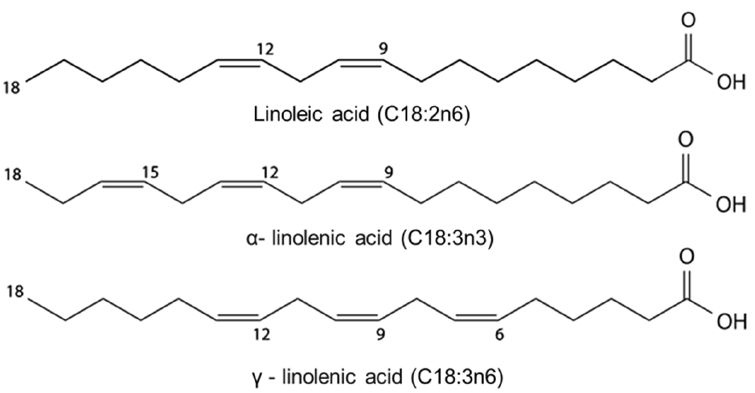
Figure 1. Chemical structures of essential (LA, ALA) and conditionally essential (GLA) fatty acids.